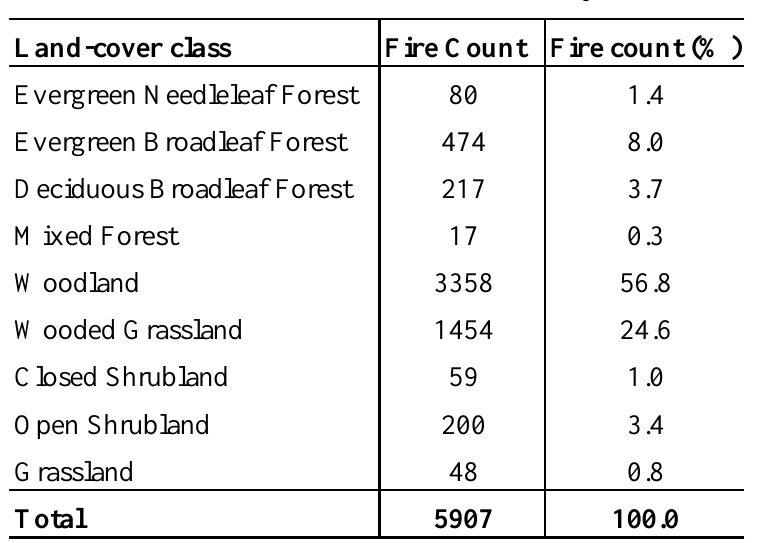
Table 2. Distribution of fire occurrence using (A)ATSR night-time satellite data for different vegetation and land cover class. Land cover class mapping was carried out using AVHRR satellite data received from Global Land Cover